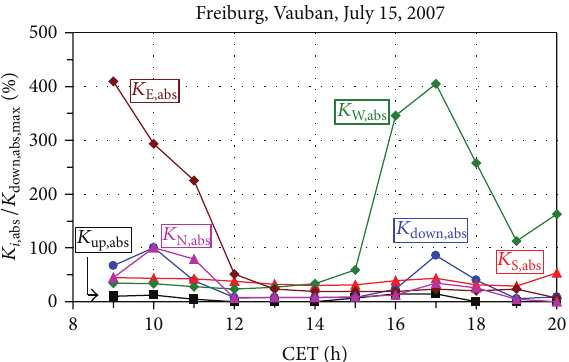
( 𝐿 = 31W/m 2 ), up , abs up , abs , max